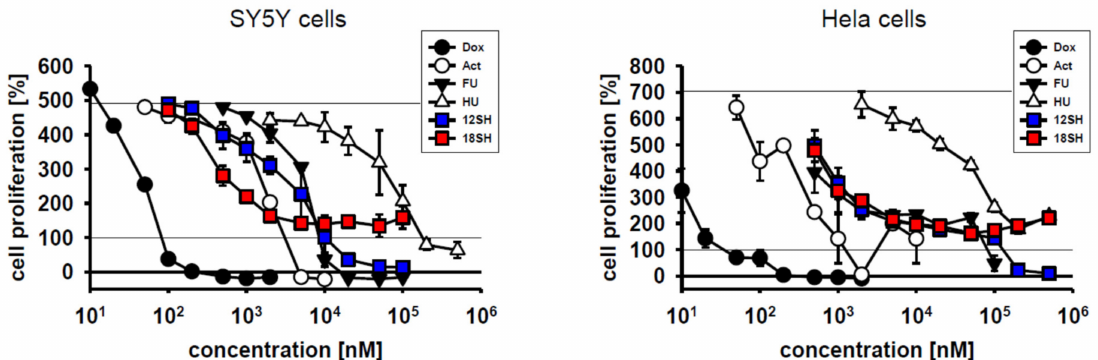
Figure 4. Cytostatic efficacy of chain-transfer agents in comparison with doxorubicin (Dox), actinomycin D (Act), 5- fluorouracil (FU) and hydroxyurea (HU). SY5Y cells and Hela cells were investigated after 3-day treatment under standard cultivation conditions as in Figure 1; the curves for 12SH and 18SH were adopted from that